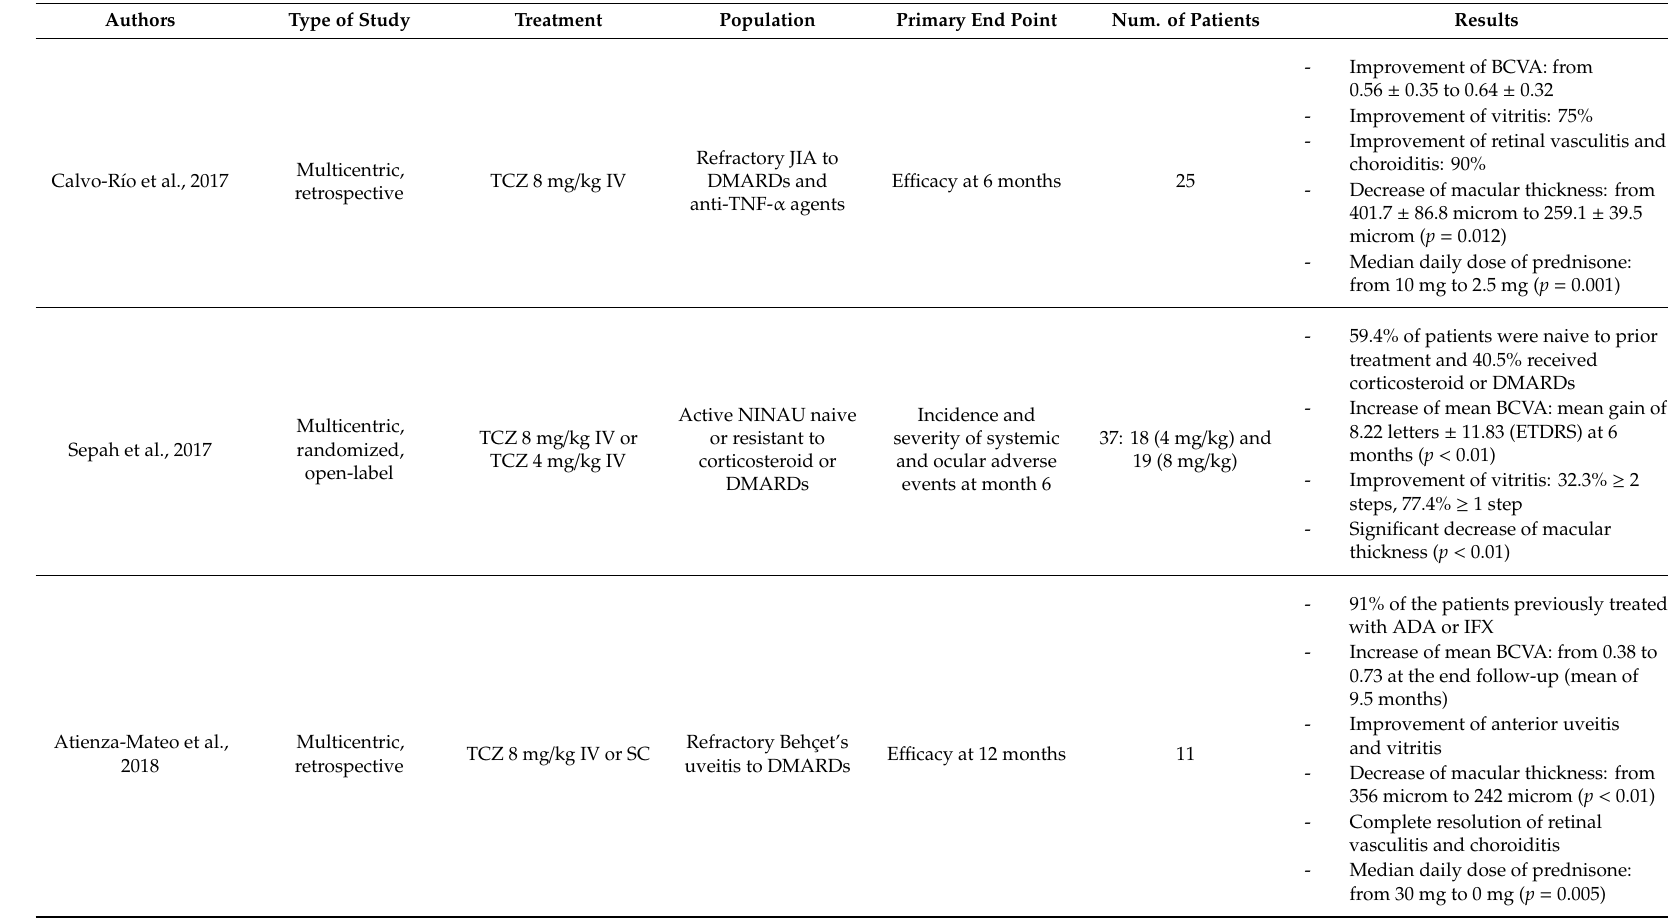
Table 3. Literature review: main data on e ffi cacy of other biotherapies (non-anti-TNF- α agents) in non-infectious